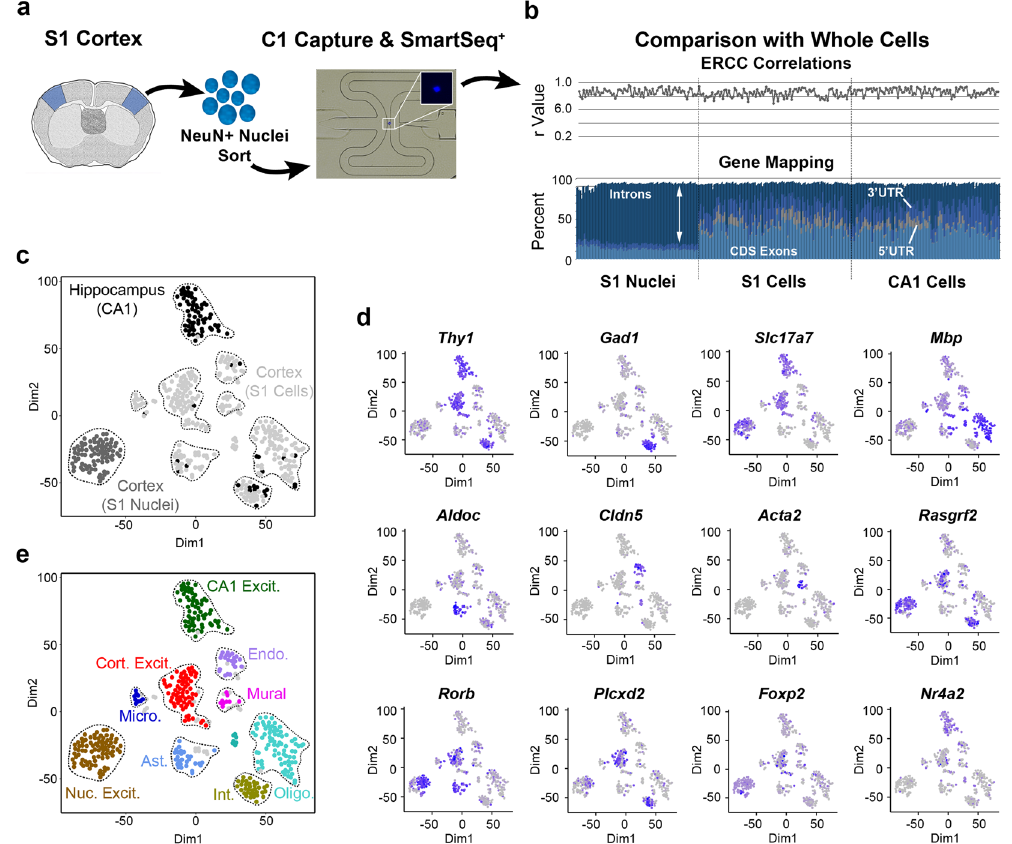
Figure 1. SNS reveals excitatory neuron identity. ( a ) Overview of the SNS pipeline. S1 mouse cortex was dissociated to single nuclei for NeuN + and DAPI + sorting and capture on C1 chips for modified SmartSeq (SmartSeq + ) reactions. Inset shows DAPI positive nuclei in the C1 capture site. ( b ) Comparison of nuclear data sets with 100 random single S1 cortical or CA1 hippocampal data sets 2 . Top panel: Pearson correlation (r) coefficients for comparison of ERCC TPM values with their input quantities. Bottom panel: proportion of genomic reads mapping to coding sequences (CDS Exons), introns, or untranslated regions (3 ′ or 5 ′ UTRs). ( c ) t-SNE plots showing cluster distribution of hippocampal CA1, cortical S1 cells and cortical S1 nuclei. ( d ) t-SNE plots as in ( c ) showing positive expression levels (low – gray; high – blue) of cell type marker genes for oligodendrocytes ( Mbp ), astrocytes ( Aldoc ), endothelial cells ( Cldn5 ), mural cells ( Acta2 ), neurons ( Thy1 ), inhibitory neurons ( Gad1 ), excitatory neurons ( Slc17a7 ), and excitatory neuron subtypes Rasgrf2 (layer 2–3), Rorb (layer 4), Plcxd2 (layer 5), FoxP2 (layer 6) and Nr4a2 (layer 6b) 2, 29 . ( e ) t-SNE plots showing expected identity of cluster groupings based on markers in ( d ) (Table S1, ambiguous data sets defined in Methods are shown in